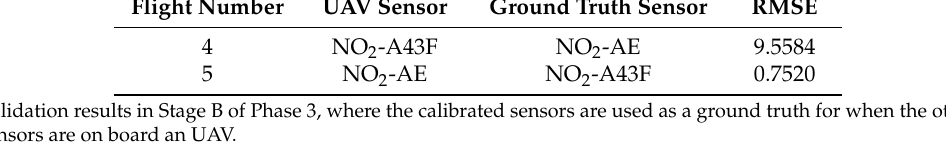
Figure 6. ( a ) Flight path and ppm concentration during Flight 4 of Stage B during Phase 3 of calibrating electrochemical sensors, where the NO 2 -A43F sensor is mounted on the UAV; ( b ) The calibrated sensor concentration is compared to the ground truth concentration.